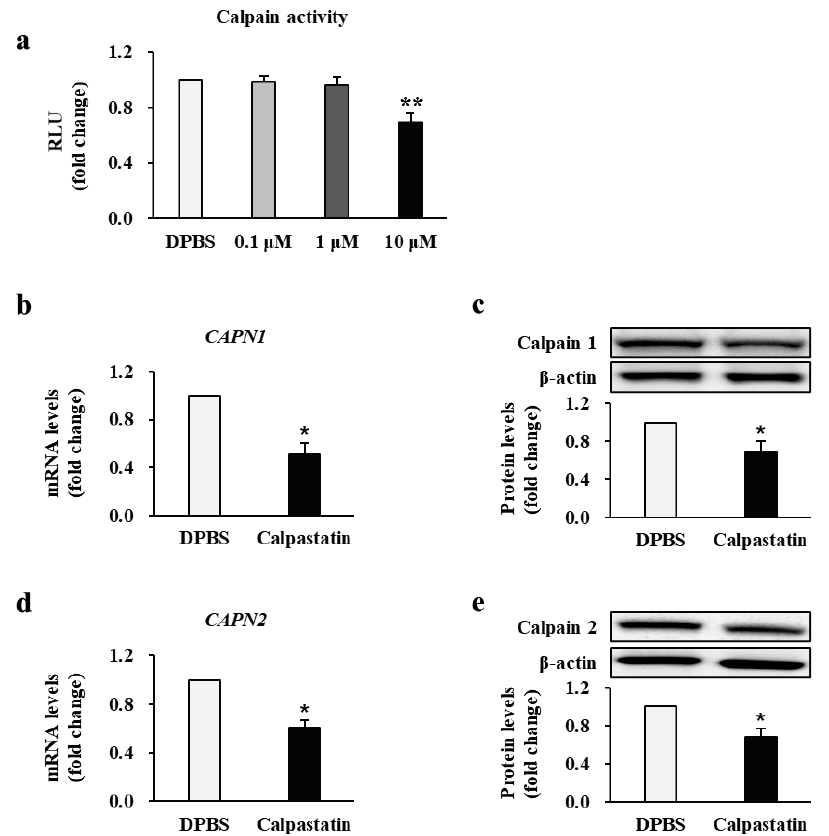
Figure 4. Effect of calpastatin on the activity and expression of calpain in burn-wound fibroblasts (BFs) of patients. ( a ) Calpain activity and mRNA and protein expression levels of ( b , c ) calpain-1 and ( d , e ) calpain-2 in BFs treated with 10 μ M calpastatin for 48 h compared with those in Dulbecco’s phosphate-buffered saline (DPBS)-treated BFs. Activity and expression levels were normalized to those of DPBS-treated BFs for each patient. DPBS: DPBS-treated BFs; Calpastatin: Calpastatin-treated BFs; RLU: Relative light units. * p < 0.05 and ** p < 0.01. Data are expressed as mean ± standard error of the mean, n = 34 (each group).